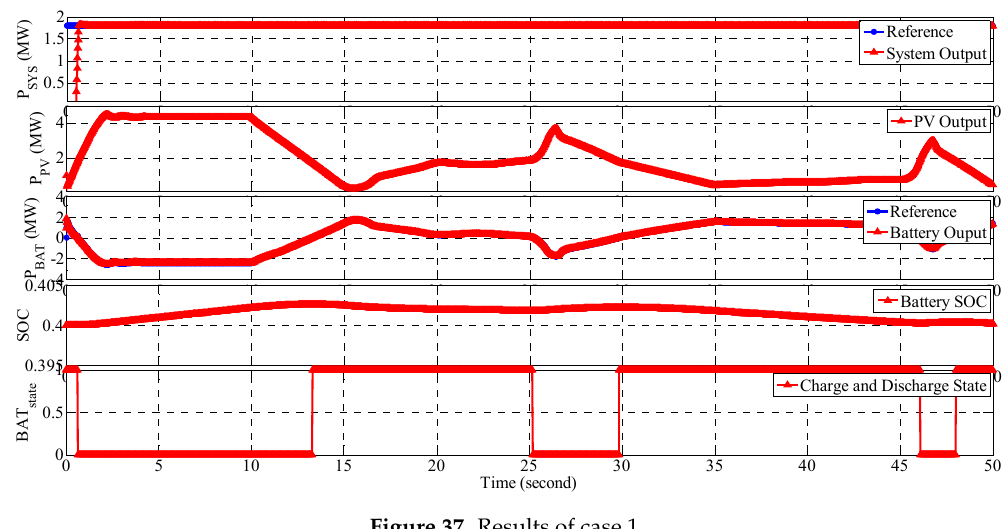
Figure 37. Results of case 1.